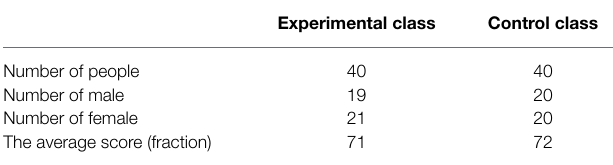
TABLE 1 | Introduction to the basic situation of the two